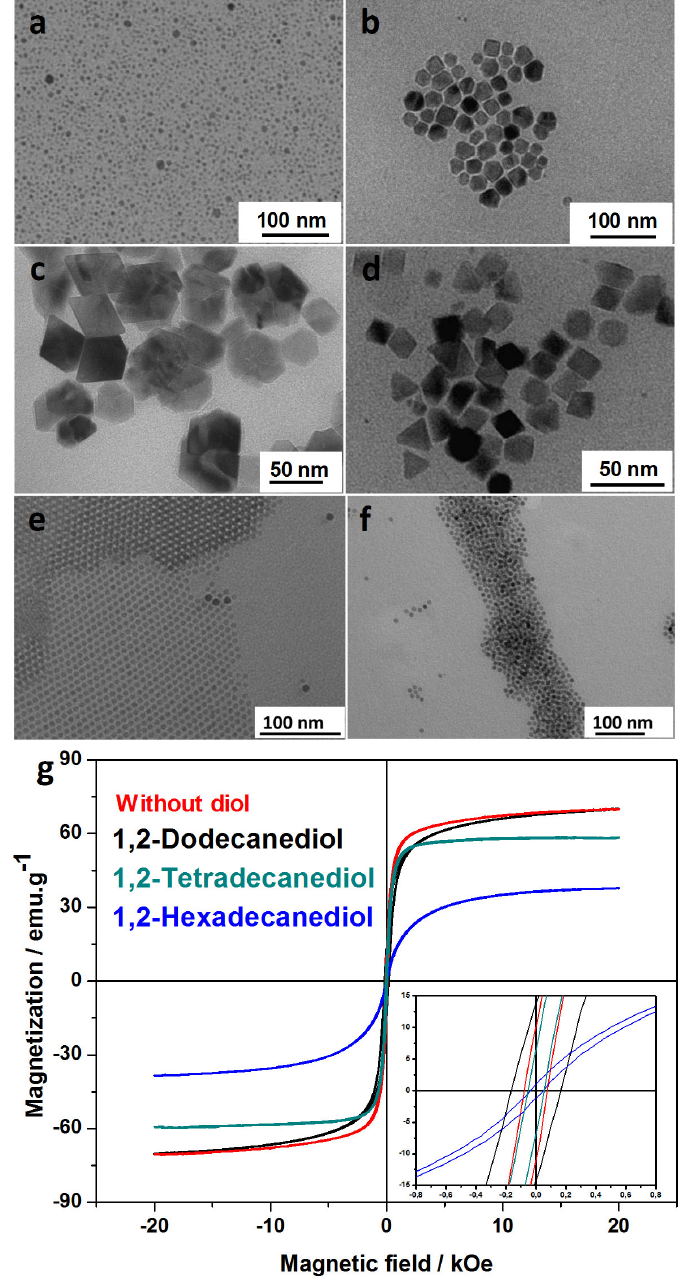
Figure 2 - Transmission electron microscopy (TEM) images of magnetite nanoparticles synthesized via modified polyol process using benzyl ether as the solvent and changing the diol hydrocarbon chain: ( a ) 1,2-hexadecanediol, ( b ) 1,2-tetradecanediol, ( c ) 1,2-dodecanediol and ( d ) without diol. TEM images of magnetite nanoparticles obtained by simple thermal decomposition method in polyol absence and both different solvent and final temperature: ( e ) 1-octadecene, 315 °C (self-assembled) and ( f ) docosane, 340 °C. ( g ) Magnetic hysteresis loops at 300 K of magnetite nanoparticle obtained via the modified polyol process according to the diol nature and TEM images shown in